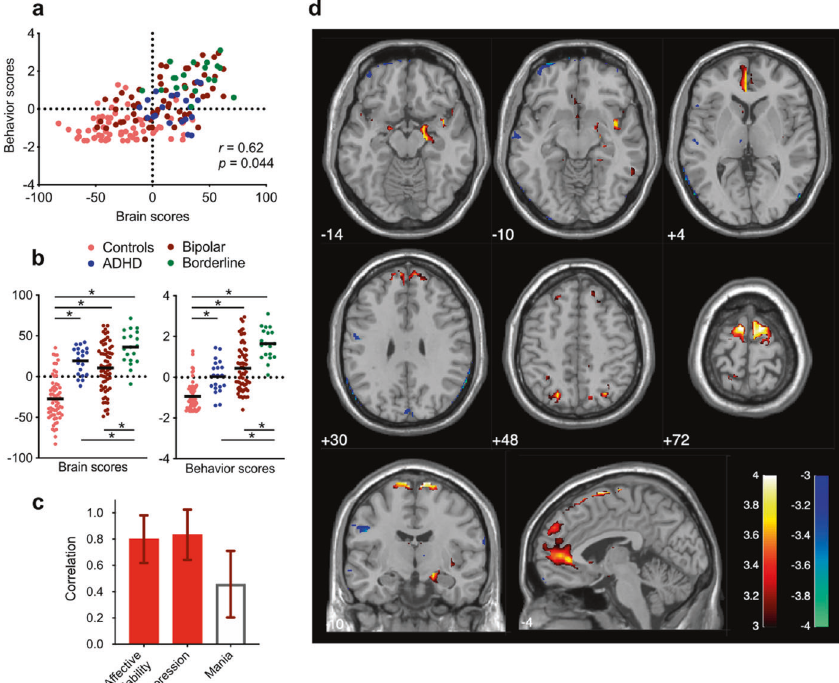
Fig. 1 The fi rst latent component (LC1) is characterized by high emotion dysregulation. a PLS correlation between individual brain and behavior scores for LC1. Each dot is a participant from any of the four diagnostic groups. b Group differences in brain and behavior scores for LC1. Bold lines are mean scores for each group, while asterisks indicate two-sample t -tests that have survived to FDR correction ( q < 0.05). Controls have signi fi cantly lower brain and behavior scores compared to all patient groups. BPD patients have signi fi cantly higher brain and behavior scores compared to ADHD and BD patients. c Greater depression and affective lability characterize the behavioral pattern of LC1 (see Table S1). Mania did not have a strong contribution to LC1 ( z < 3). Loadings are Pearson ’ s correlations between participants ’ original behavioral data and their behavior scores, and error bars indicate bootstrap-estimated standard deviations. d LC1 is characterized by increased BOLD signal variability in the left ventromedial PFC, bilateral dorsomedial PFC, subgenual ACC, bilateral amygdala, right hippocampus, right insula, and bilateral motor cortex, as well as decreased BOLD signal variability in occipital regions (see Table S2 for MNI coordinates of peaks of all signi fi cant clusters). Loadings are z -scores obtained from bootstrapping, thresholded at absolute values ≥ 3 ( p <